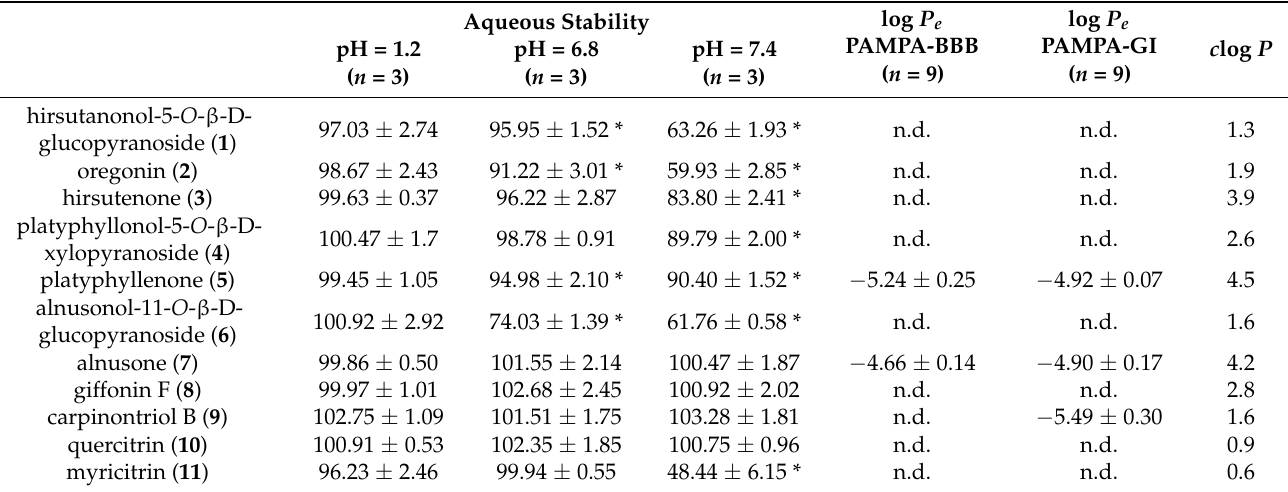
Table 2. Results of the aqueous stability studies: compound concentration after 4 h of incubation at 37 ◦ C compared to the initial value (%) ( n = 3) and the PAMPA experiments’ log P e values ( n = 9). Aqueous Stability log P